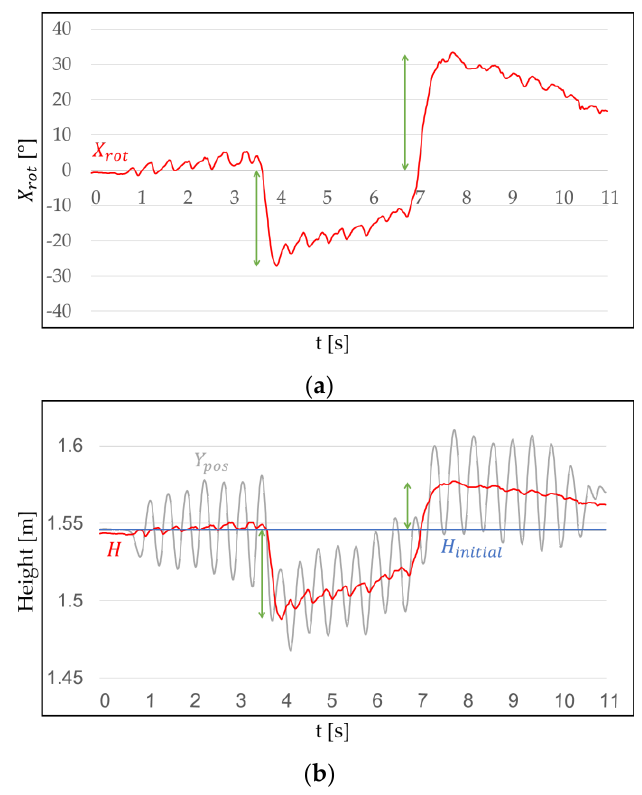
Figure 3. Change in H when 𝑋 𝑟𝑜𝑡 changes while performing WIP: ( a ) 𝑋 𝑟𝑜𝑡 when the head is tilted down or up; ( b ) H , 𝑌 𝑝𝑜𝑠 and 𝐻 𝑖𝑛𝑖𝑡𝑖𝑎𝑙 , where H is on the central axis of the cycle. This will be smaller or bigger depending on 𝑋 𝑟𝑜𝑡 . Green arrows indicate that H varies with the head pitch.